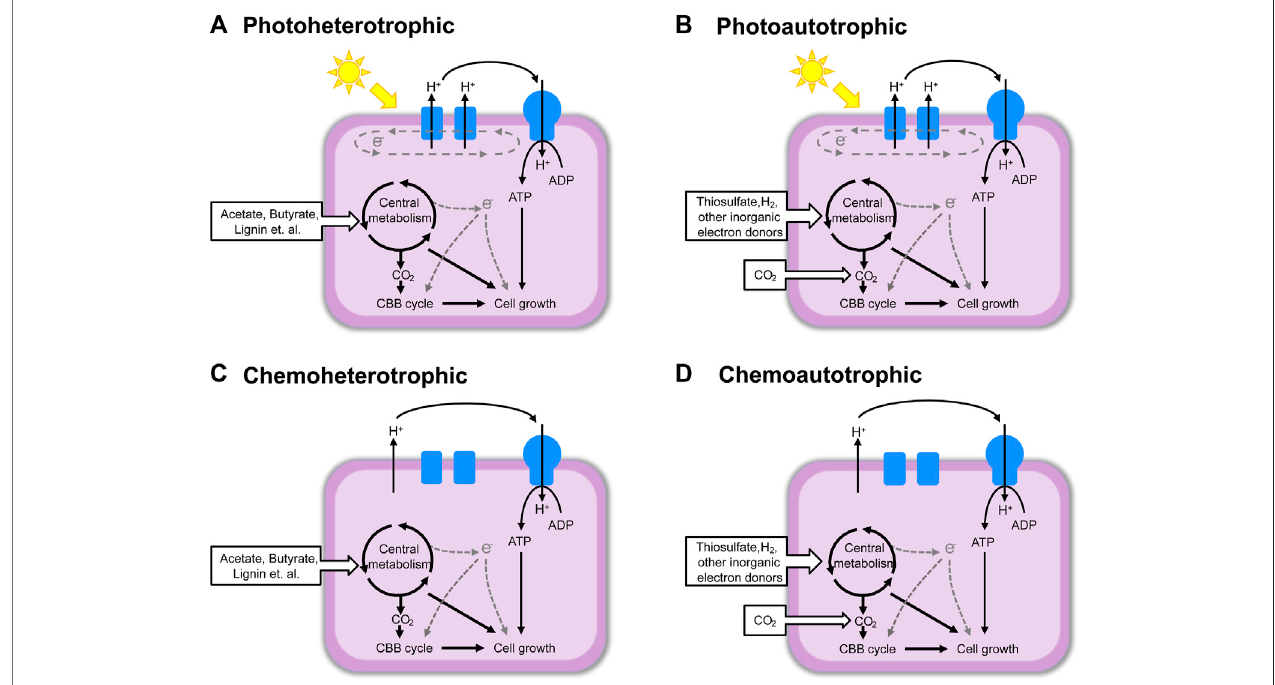
FIGURE 1 | The four types of metabolism of R. palustris . (A) Photoheterotrophic; (B) Photoautotrophic; (C) Chemoheterotrophic; (D) Chemoautotrophic. This fi gure was modi fi ed according to the fi gure in reference (Larimer et al., 2003).